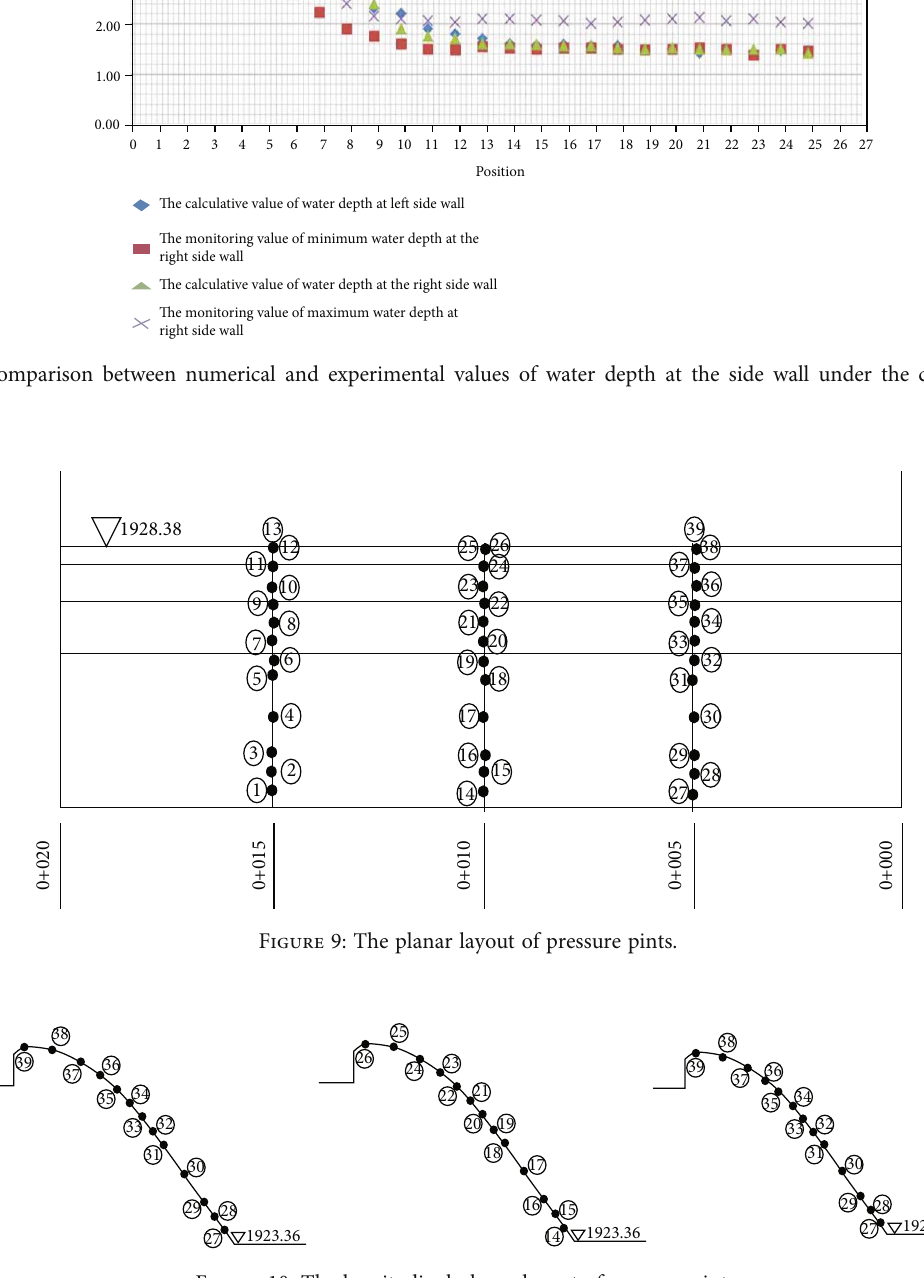
Figure 10: The longitudinal planar layout of pressure pints.